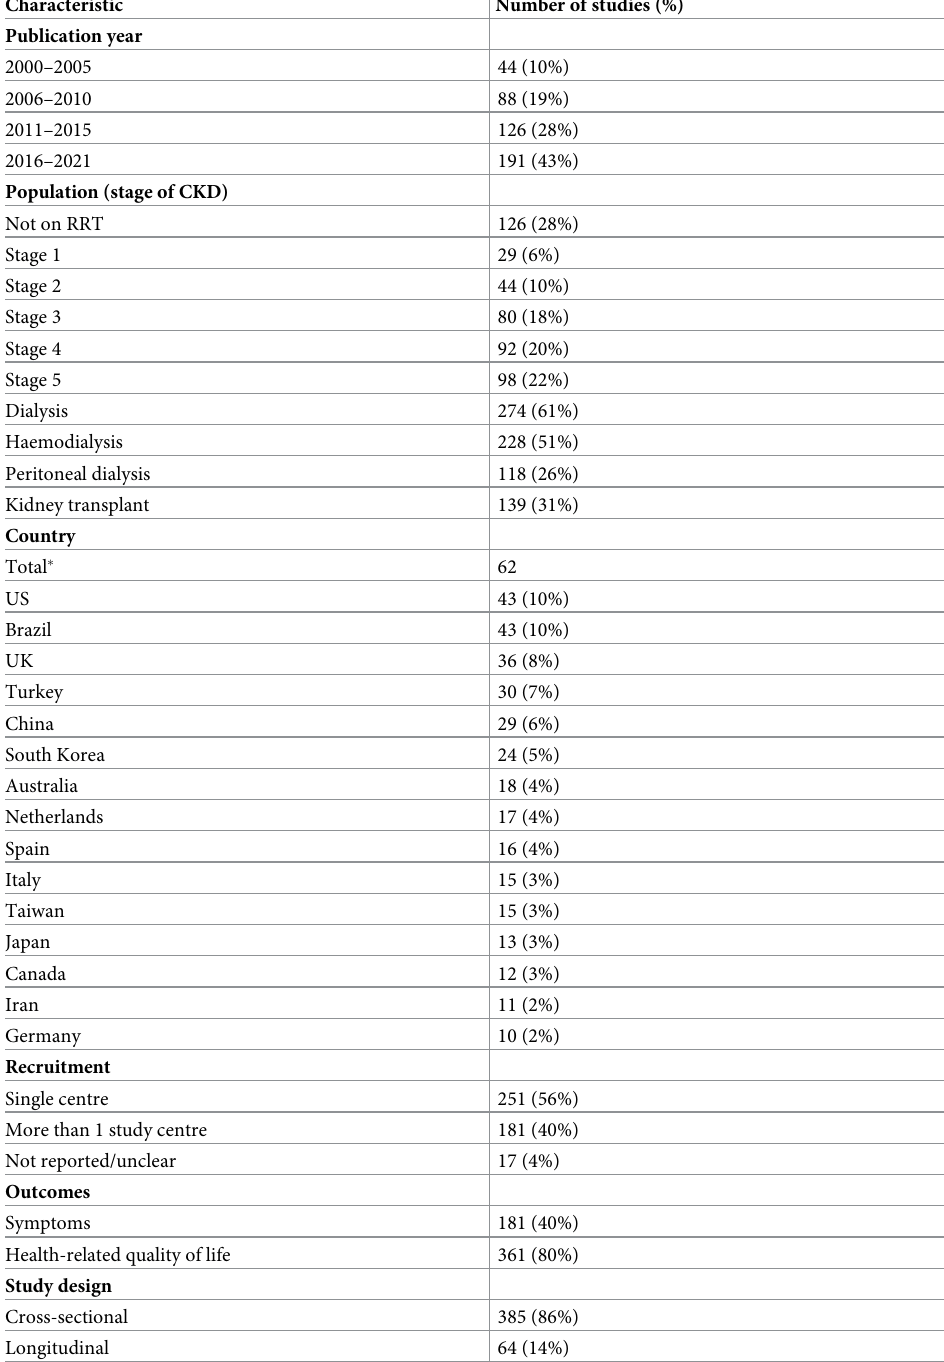
Table 1. Characteristics of the included 449